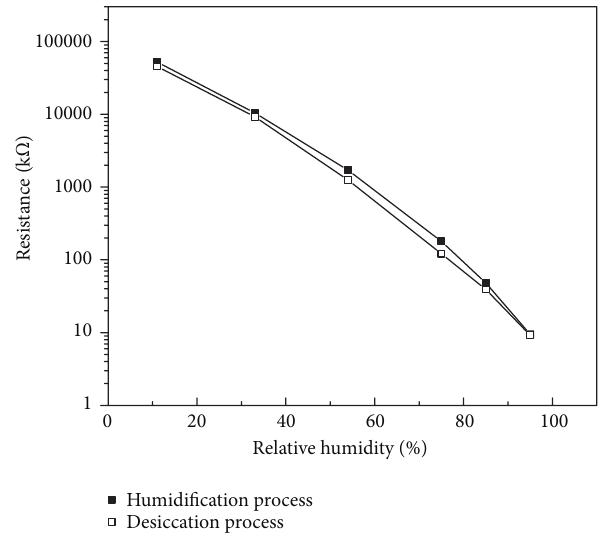
Figure 7: Hysteresis characteristics of 10mol% La 2 O 3 doped CeO 2 humidity